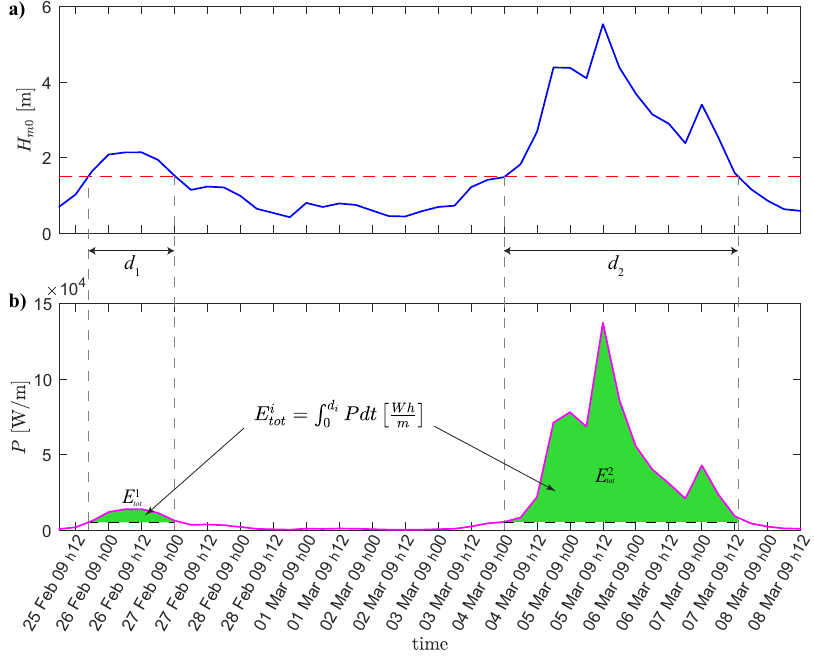
Figure 3. ( a ) Spectrally significant wave height H m 0 , during the storms of 25 February and 4 March 2009 at the prediction Point P3. The dashed red line is the spectrally significant wave height threshold h t = 1.5 m, d 1 and d 2 are storm duration. ( b ) Energy flux during time and total storm